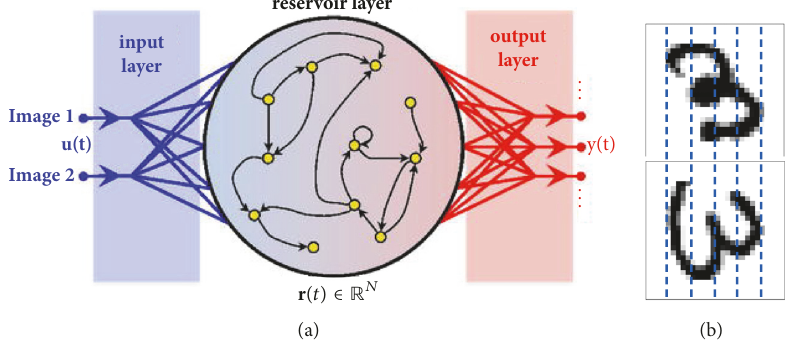
󳨀→ 𝑢(𝑡) , reservoir state vector at a single time by